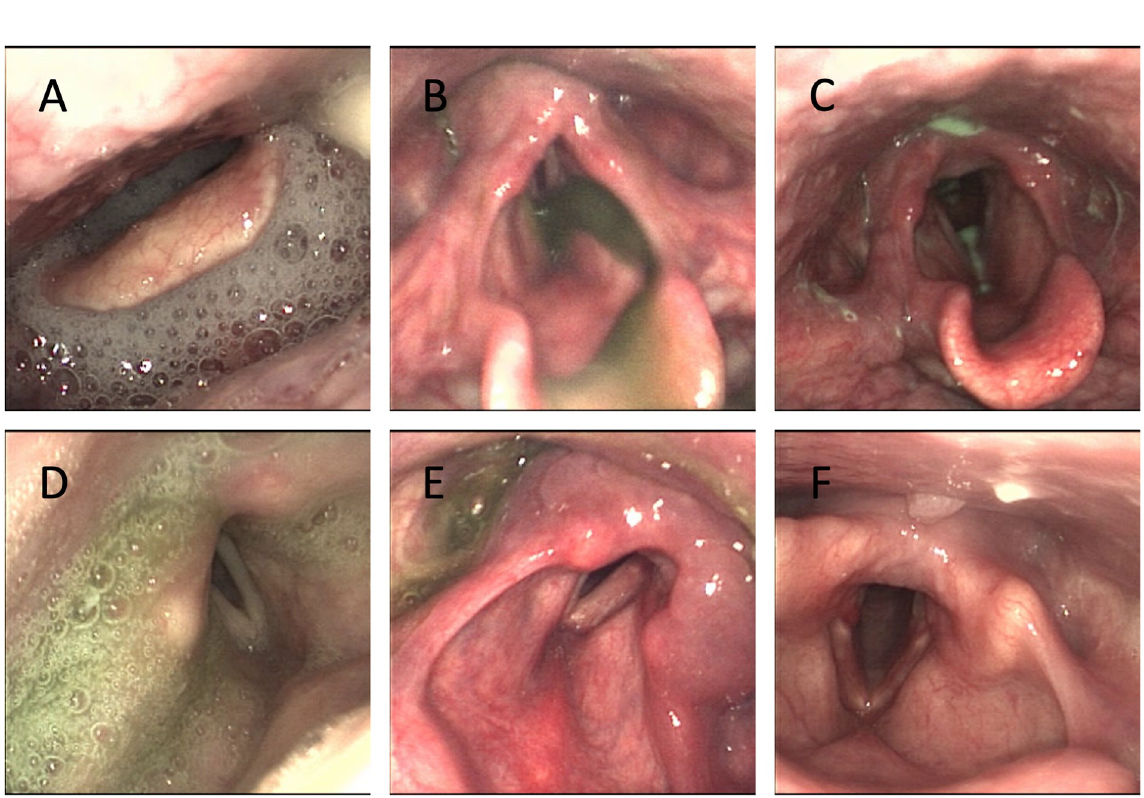
Fig 3. Examples of findings during the FEES. A) Secretions in vallecula and hypopharynx before first bolus. B) Penetration to the level of the vocal folds. C) Aspiration of thin liquid. D) Residue in hypopharynx and larynx after swallow. E) Edema in the arytenoid region on the left side. F) Bilateral vocal fold